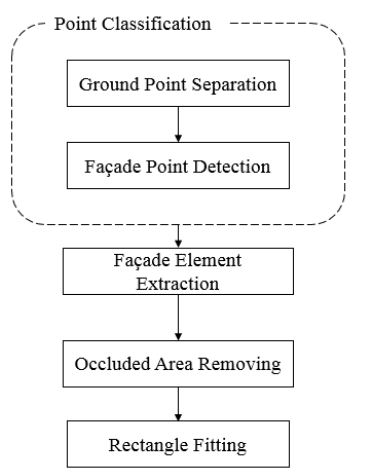
Figure 1. Overview of the algorithm